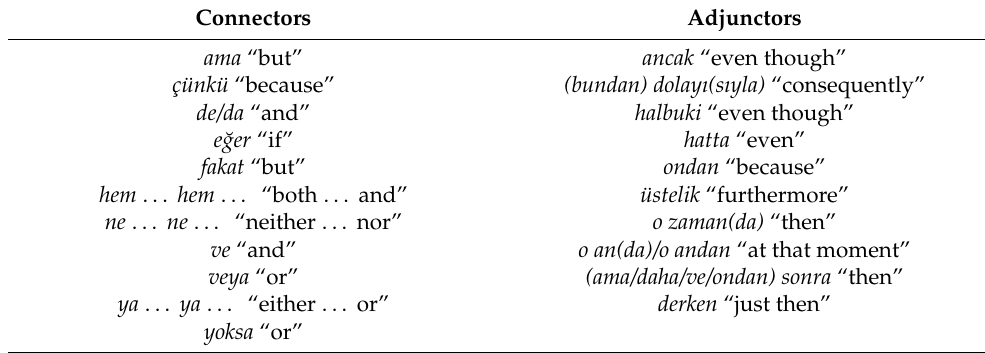
Table 1. Connectors in the Turkish